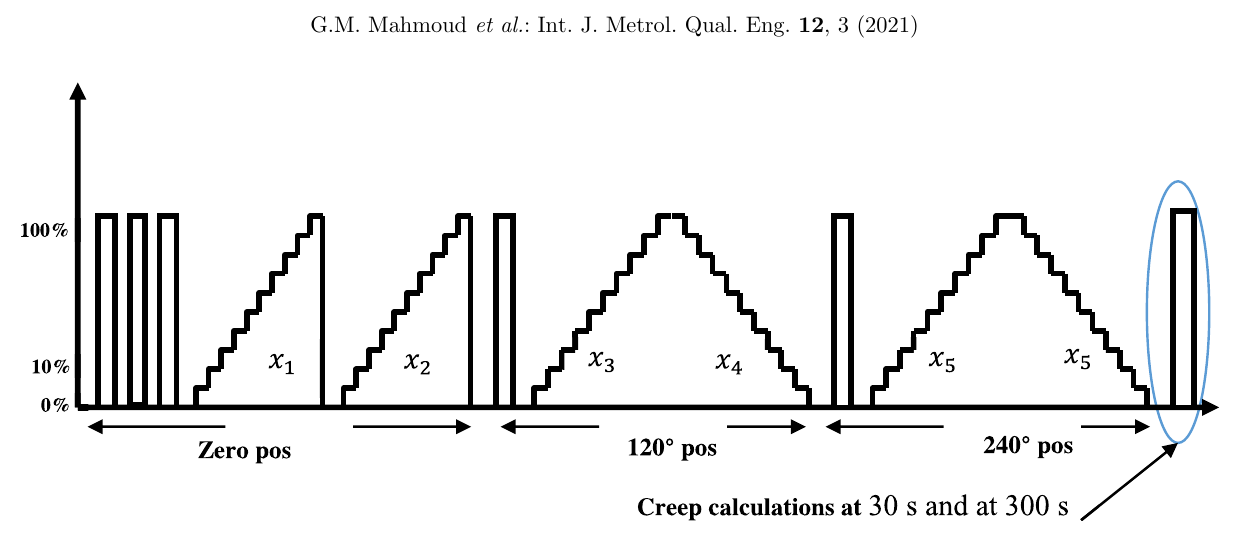
Fig. 1. Calibration procedure and series as per